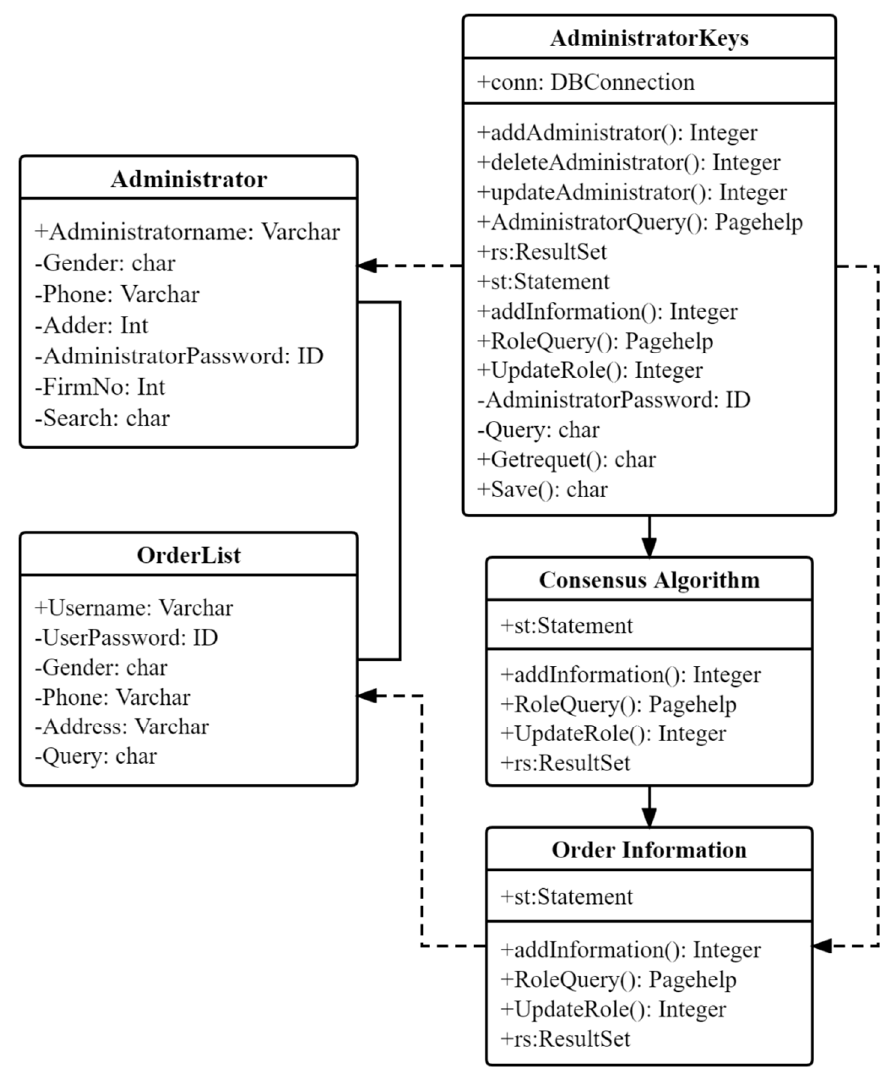
Figure 7. The order data class generation process.